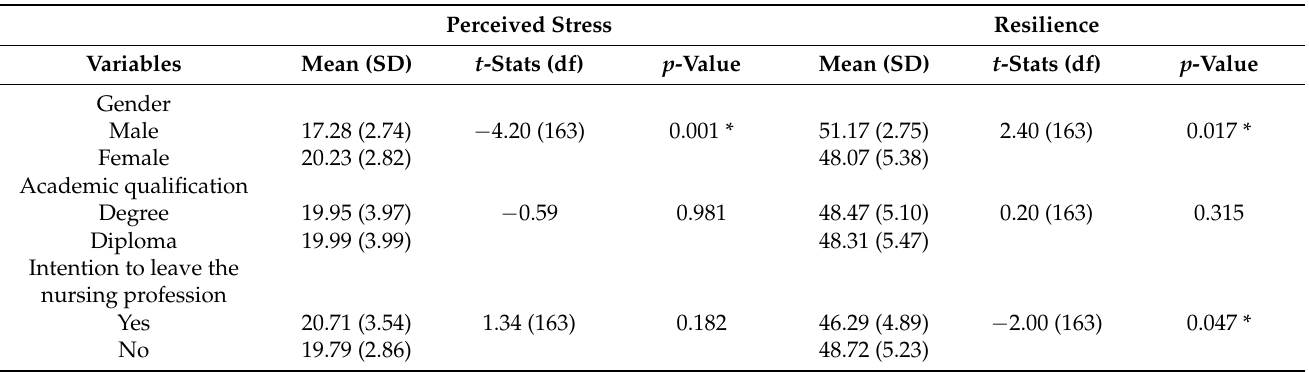
Table 2. Summary of the independent-sample t -test results comparing sociodemographic characteris- tics with perceived stress and resilience.